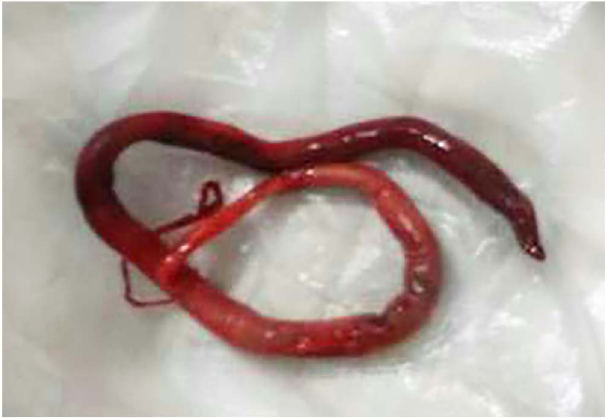
Figure 3. An adult Dioctophyma renale worm found in the patient ’ s urine.